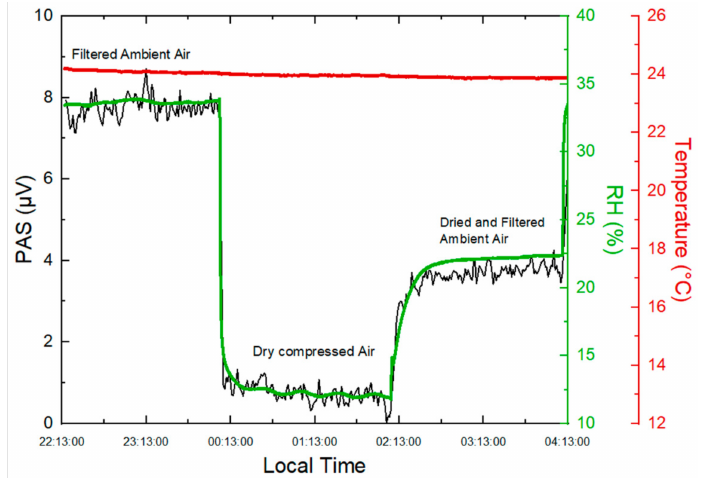
Figure 3. Time series of PAS measurements from filtered ambient air, dry compressed air, and dried and filtered ambient